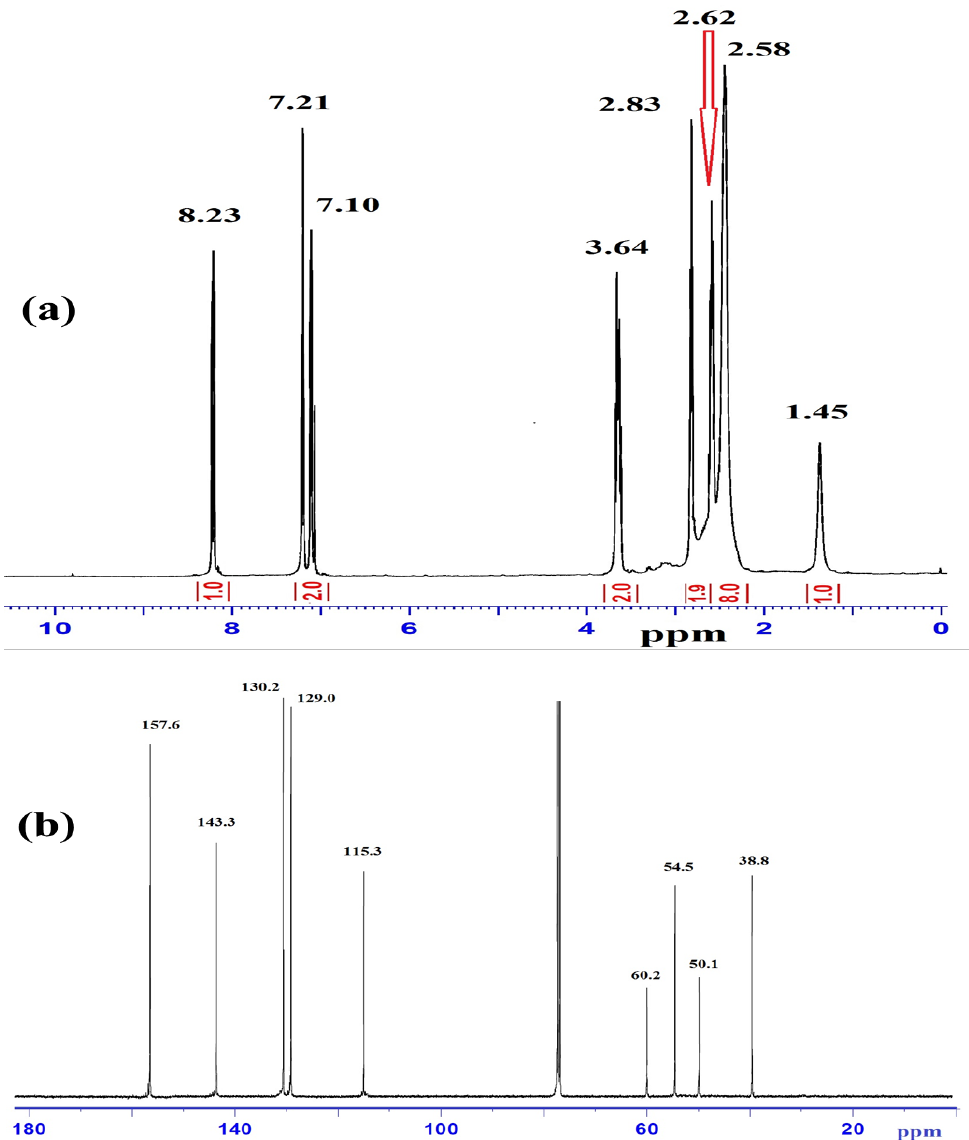
Figure 1. 1 H NMR spectra of L3 ( a ) and 13 C NMR ( b ) in CDCl 3 at room temperature.